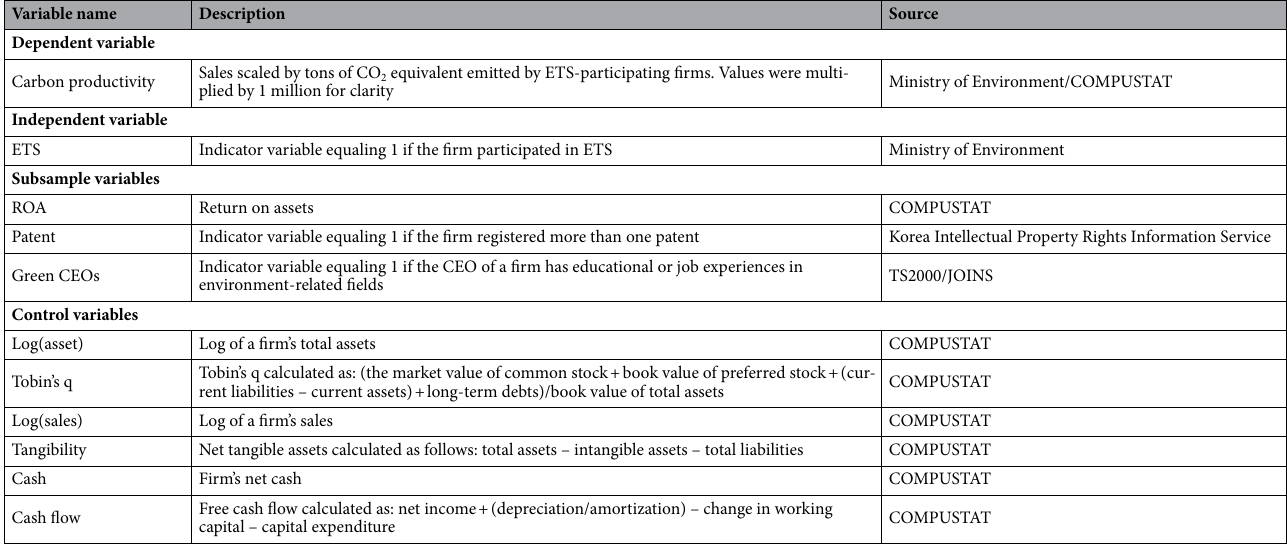
Table 4. Description and source of the variables analyzed in this